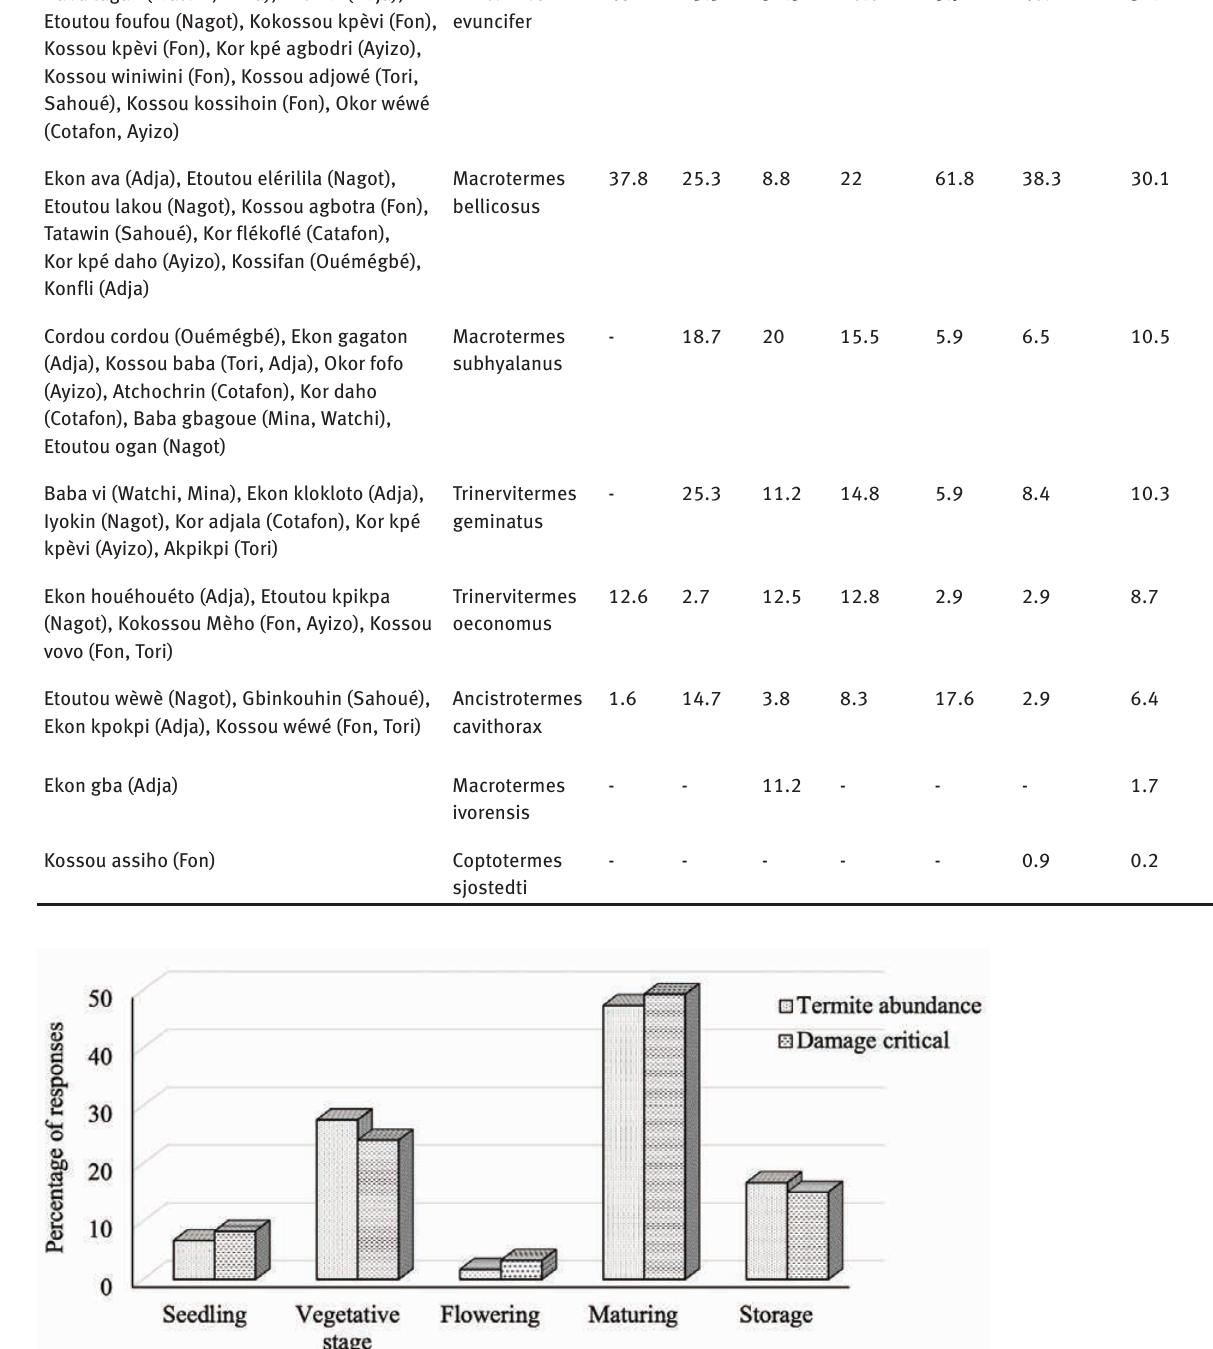
Table 4 : Maize pestiferous termite’s species identified by farmers in southern Benin (N = 273) Species of termites Percentage of responses by department guistic groups